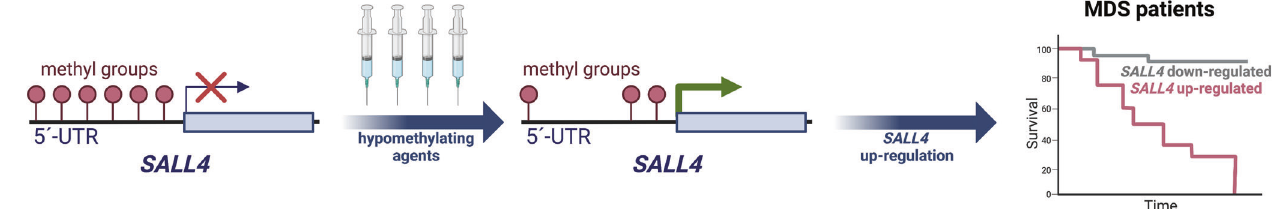
Fig. 1 Schematic of the fi ndings reported by Liu et al. Brie fl y, the study demonstrates that treatment of myelodysplastic syndrome (MDS) patients with hypomethylating agents leads to demethylation of a CpG site in the 5 ′ untranslated region (UTR) of the oncogene SALL4 resulting in increased SALL4 expression which correlates with impaired prognosis in these patients. The fi gure was created with